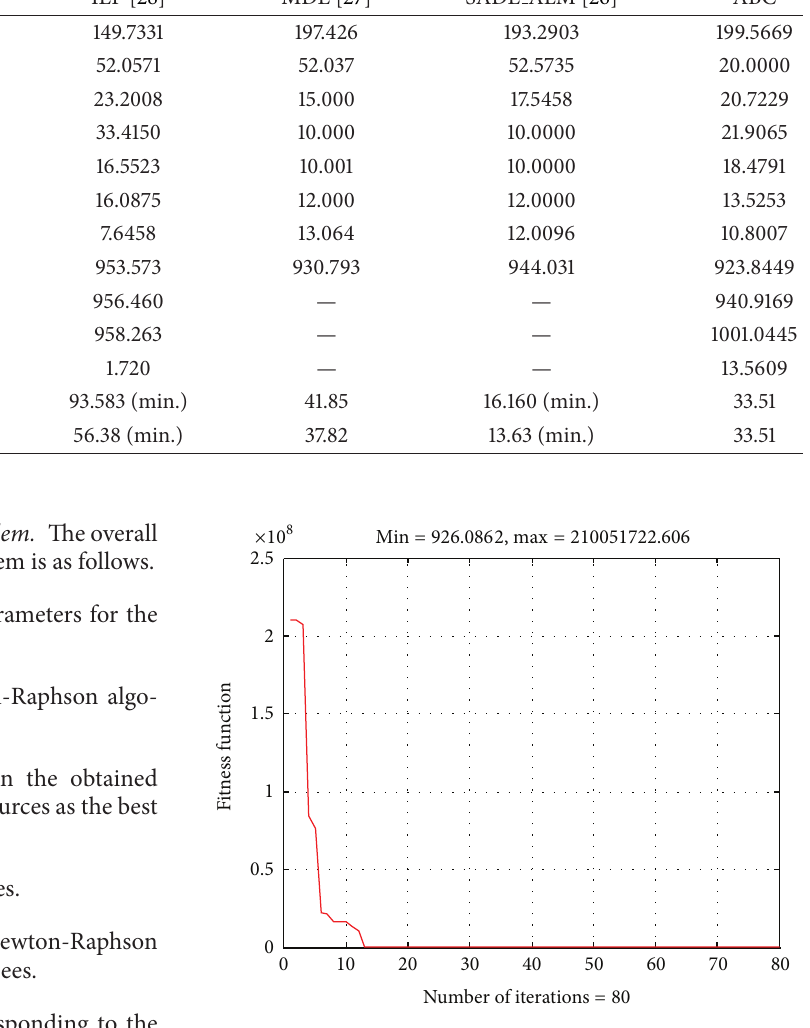
Figure 3: Convergence characteristic of the ABC algorithm for the IEEE 30-bus system with valve point